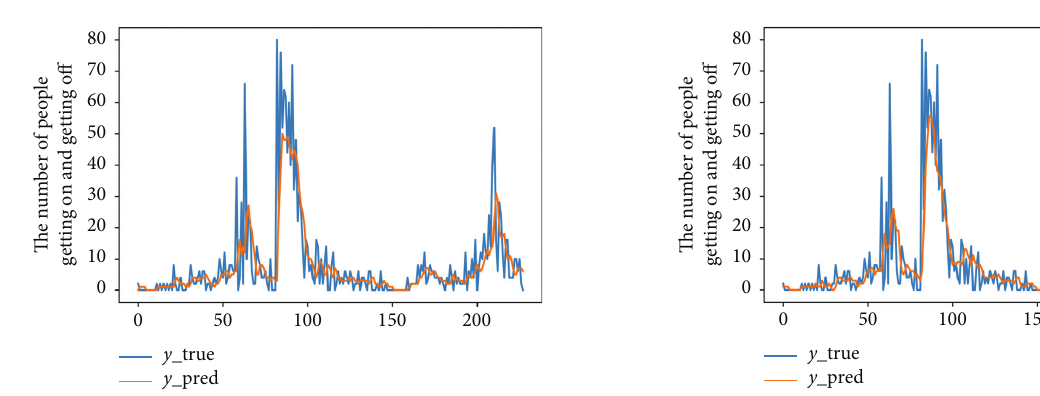
Figure 22: Regression integration prediction results when the time step is 1h.